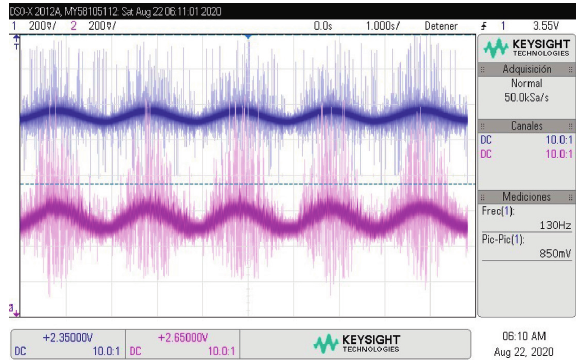
Figure 24: Desired current path (blue) and measured current (magenta).